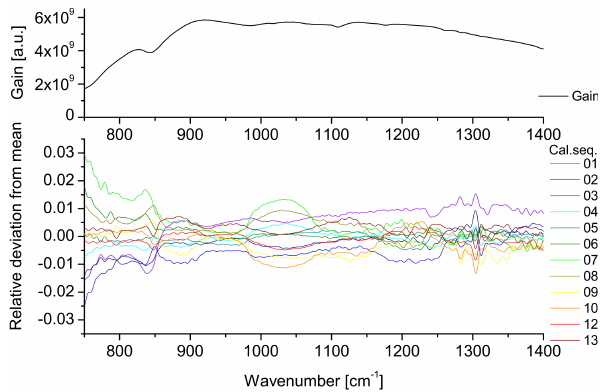
Figure 18. Mean instrument offset and deviation from the mean for the different calibration sequences during the HALO flight on 13 September